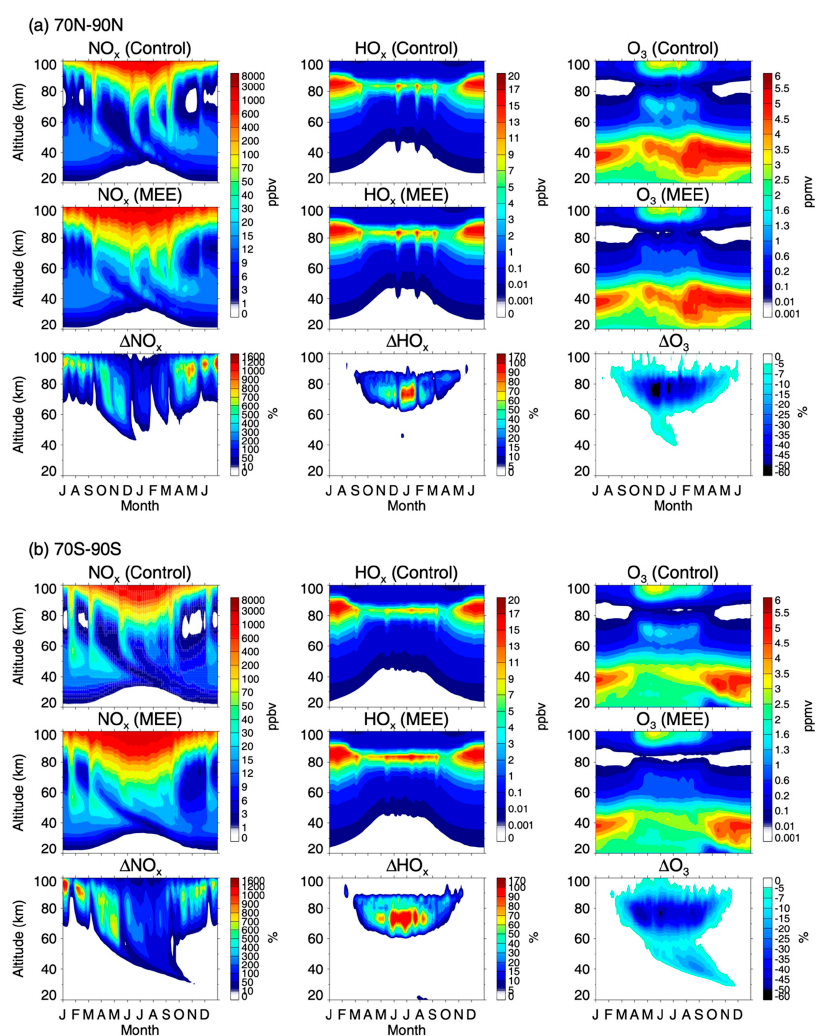
Figure 3. Seasonal variations of the daily zonal mean height profiles of NO x (left), HO x (middle), O 3 (right) VMRs are presented from the control and MEE runs and their relative changes ((MEE-Control)/Control). All values are averaged in the latitude range of 70 ◦ –90 ◦ N/S during the whole period from 2005 to 2013 with the application of a 7-day moving